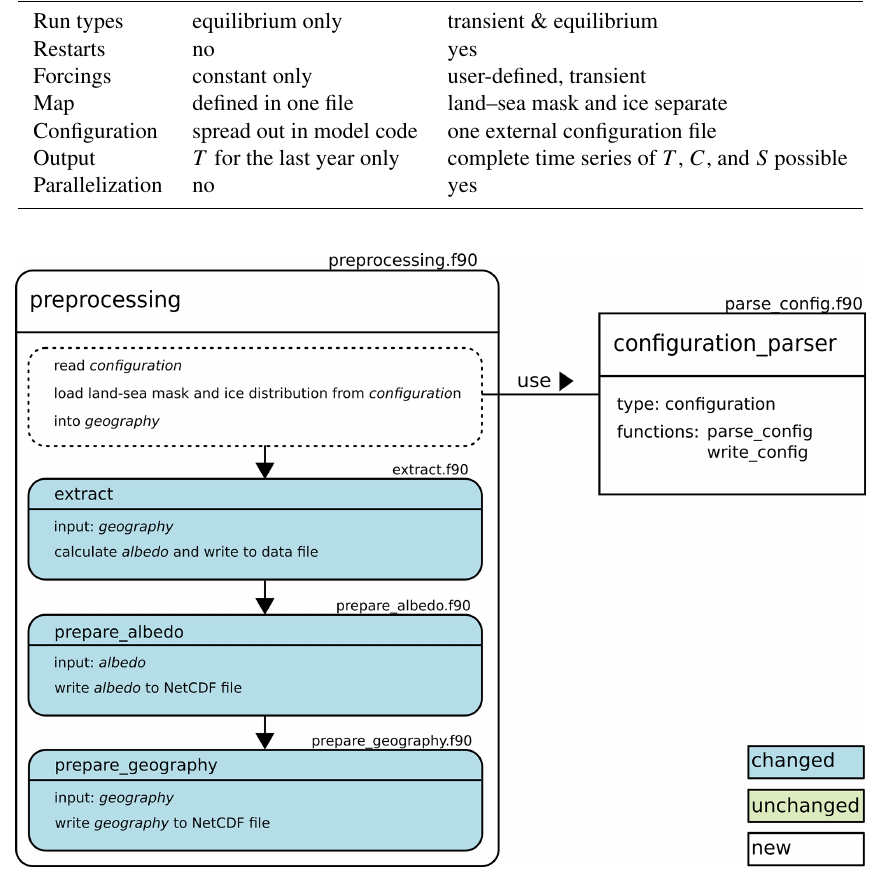
Figure 6. Preprocessing component of the model with new, changed, and unchanged features with respect to the EBM by Zhuang et al. (2017a)